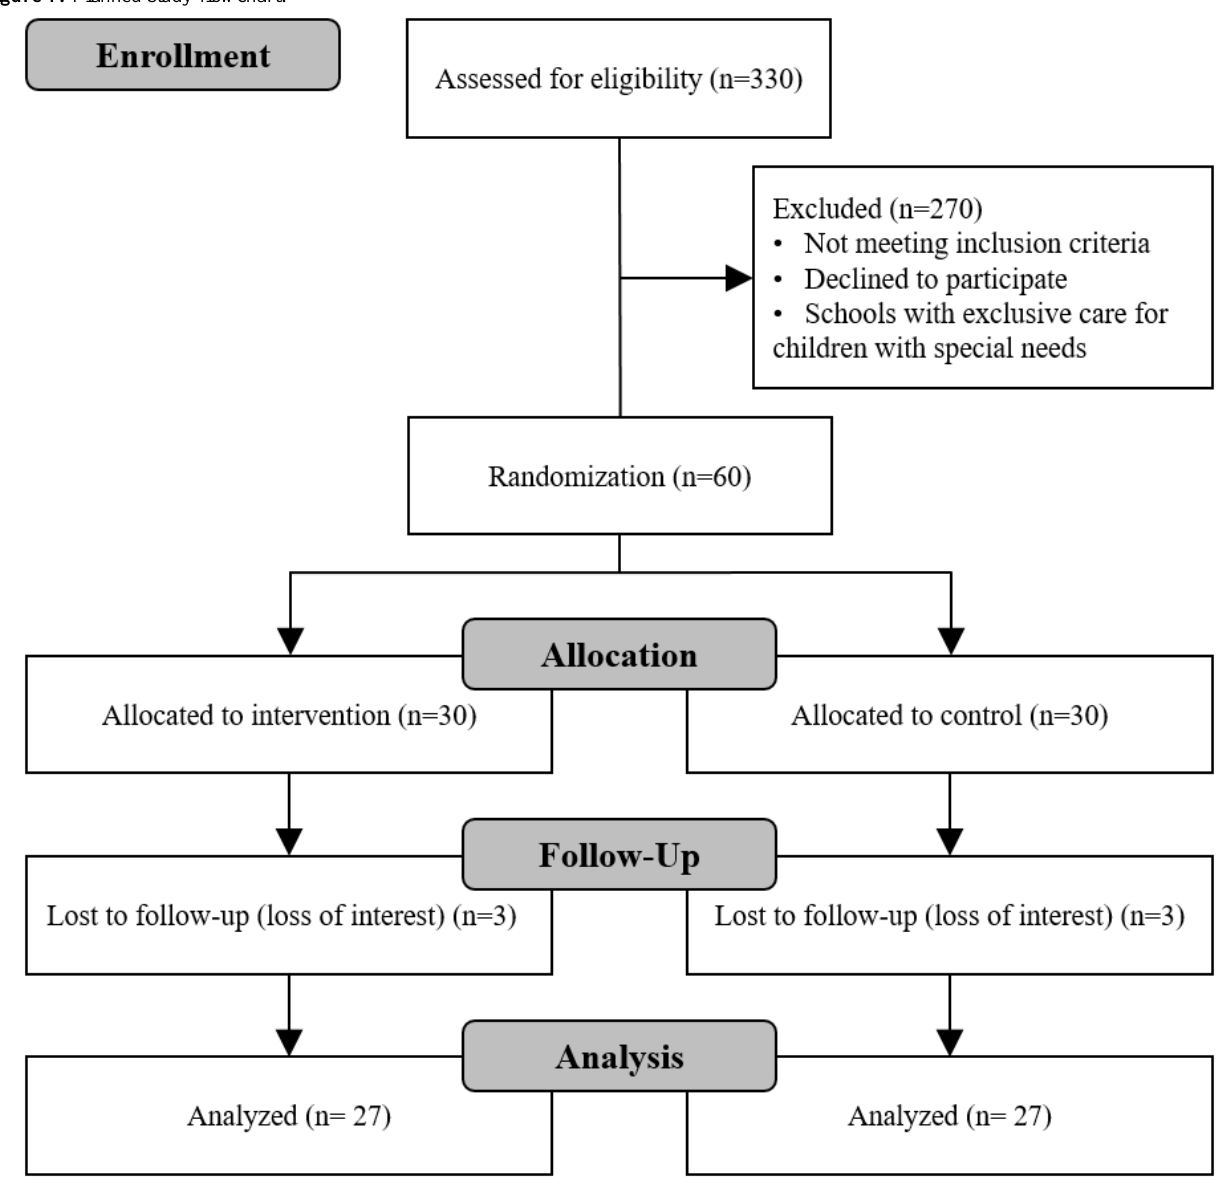
Figure 1. Planned study